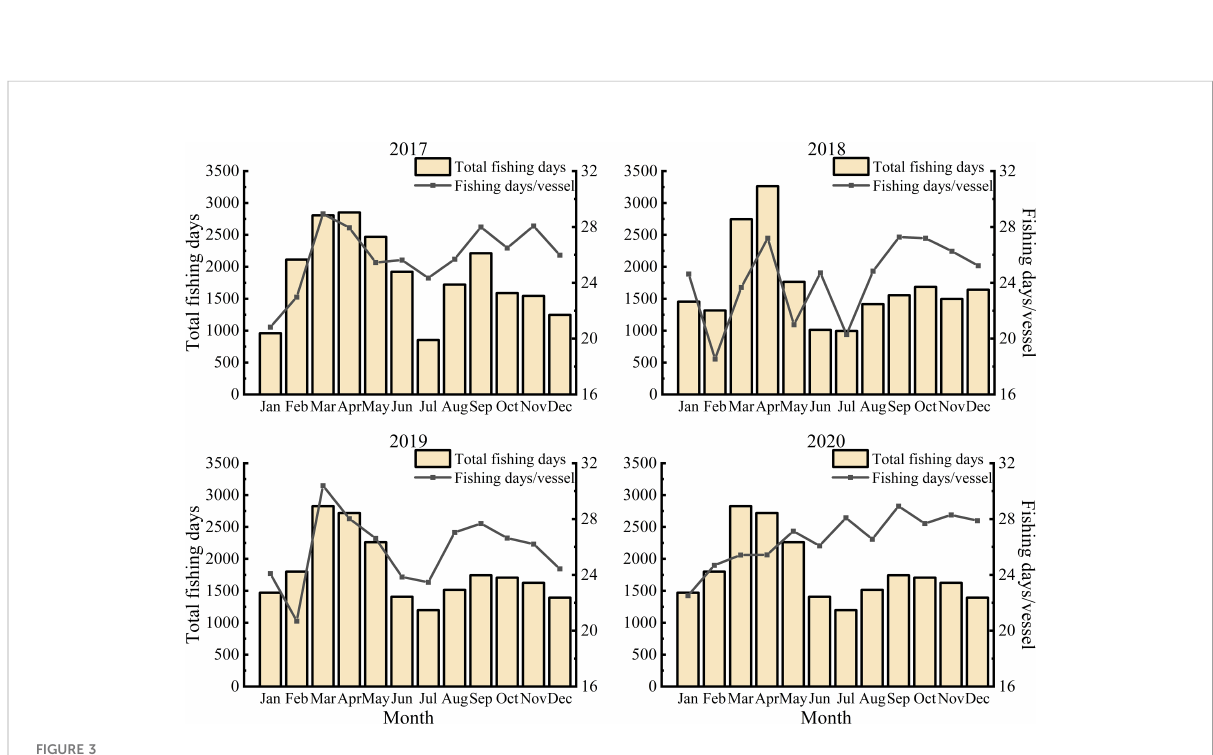
FIGURE 3 Average monthly operating days of fi shing vessels from 2017 to